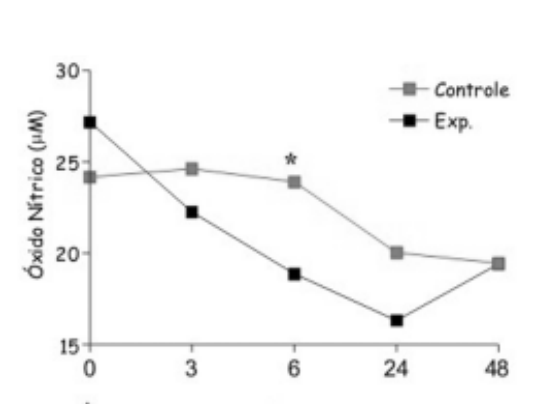
Fig. 5 - Valores de TNF α